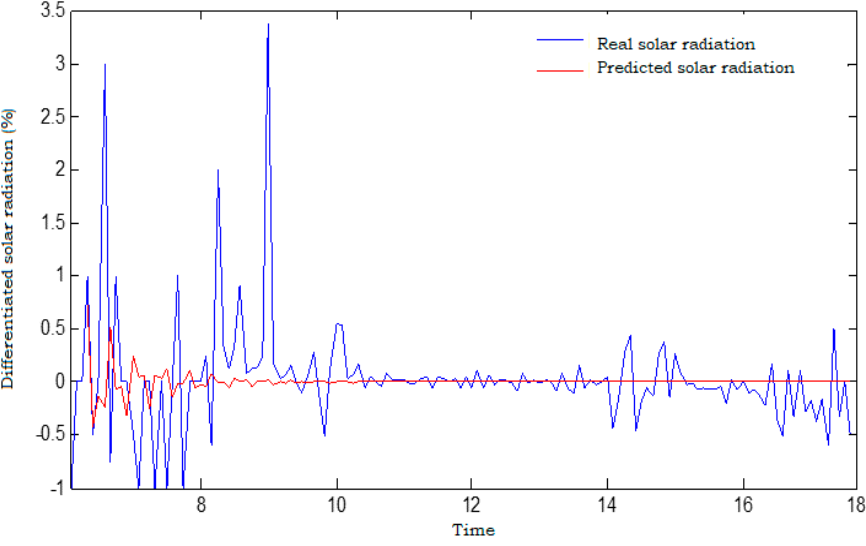
Figure 6. Real solar radiation vs. predicted one using ARMA (3,3) (for a winter day). As presented in Figure 6, ARMA (3,3) allowed us to take back the two first solar radiation peaks which do not exceed 10%; however, it failed to predict the third peak which is around 30%. Then, the predicted curve fully diverges from the real one. These results show the weakness of the ARMA model to predict solar radiation over a winter day. Figure 7 presents the error and relative error of solar radiation prediction. Relative error is around 1% in some periods of day, but it increases at other time intervals. MSE, MAE, and RMSE are calculated as presented in Table 3. Among these errors, MAE represents the smallest one, but this does not reflect the performances of ARMA (3,3). It is possible to explain the inability of ARMA (3,3) to predict solar radiation for a winter day by two main causes.